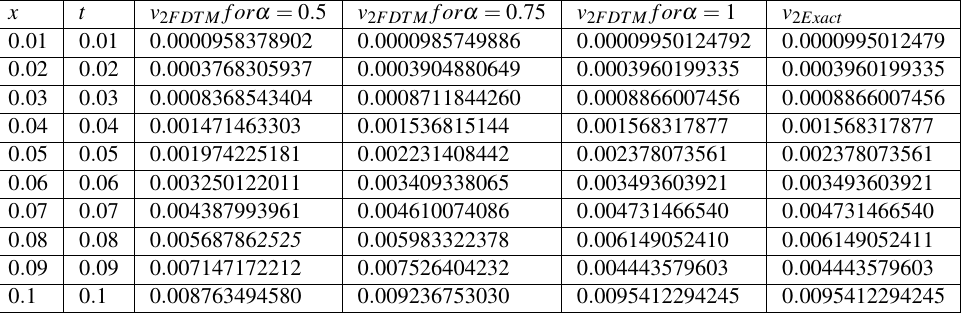
Table 4: Numerical solution of v 3 ( x , t